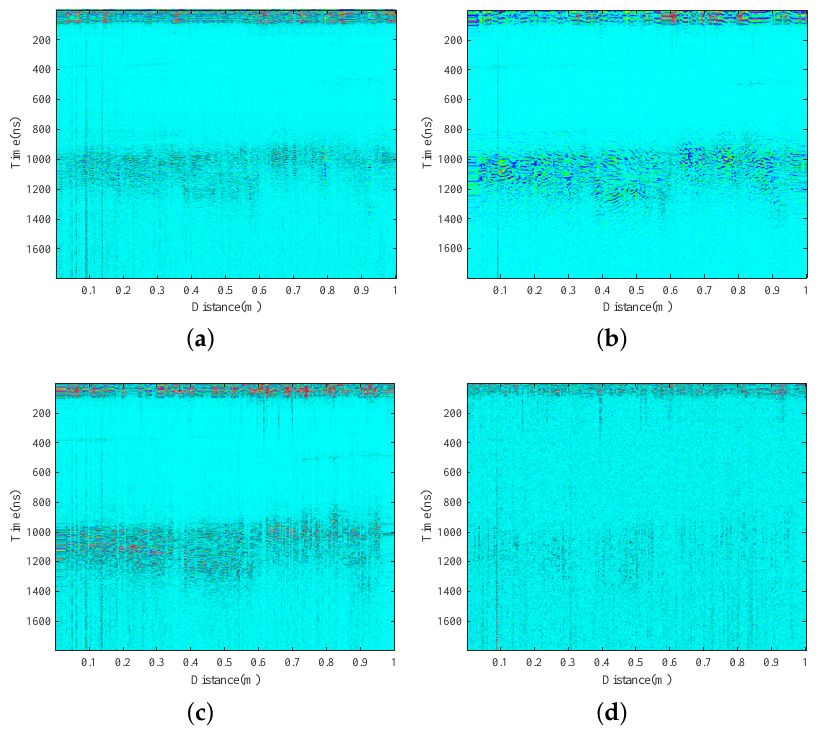
Figure 23. The IMFs obtained by WOA-VMD-BD of the measured data in HV polarization mode. ( a ) IMF1. ( b ) IMF2. ( c ) IMF3. ( d )